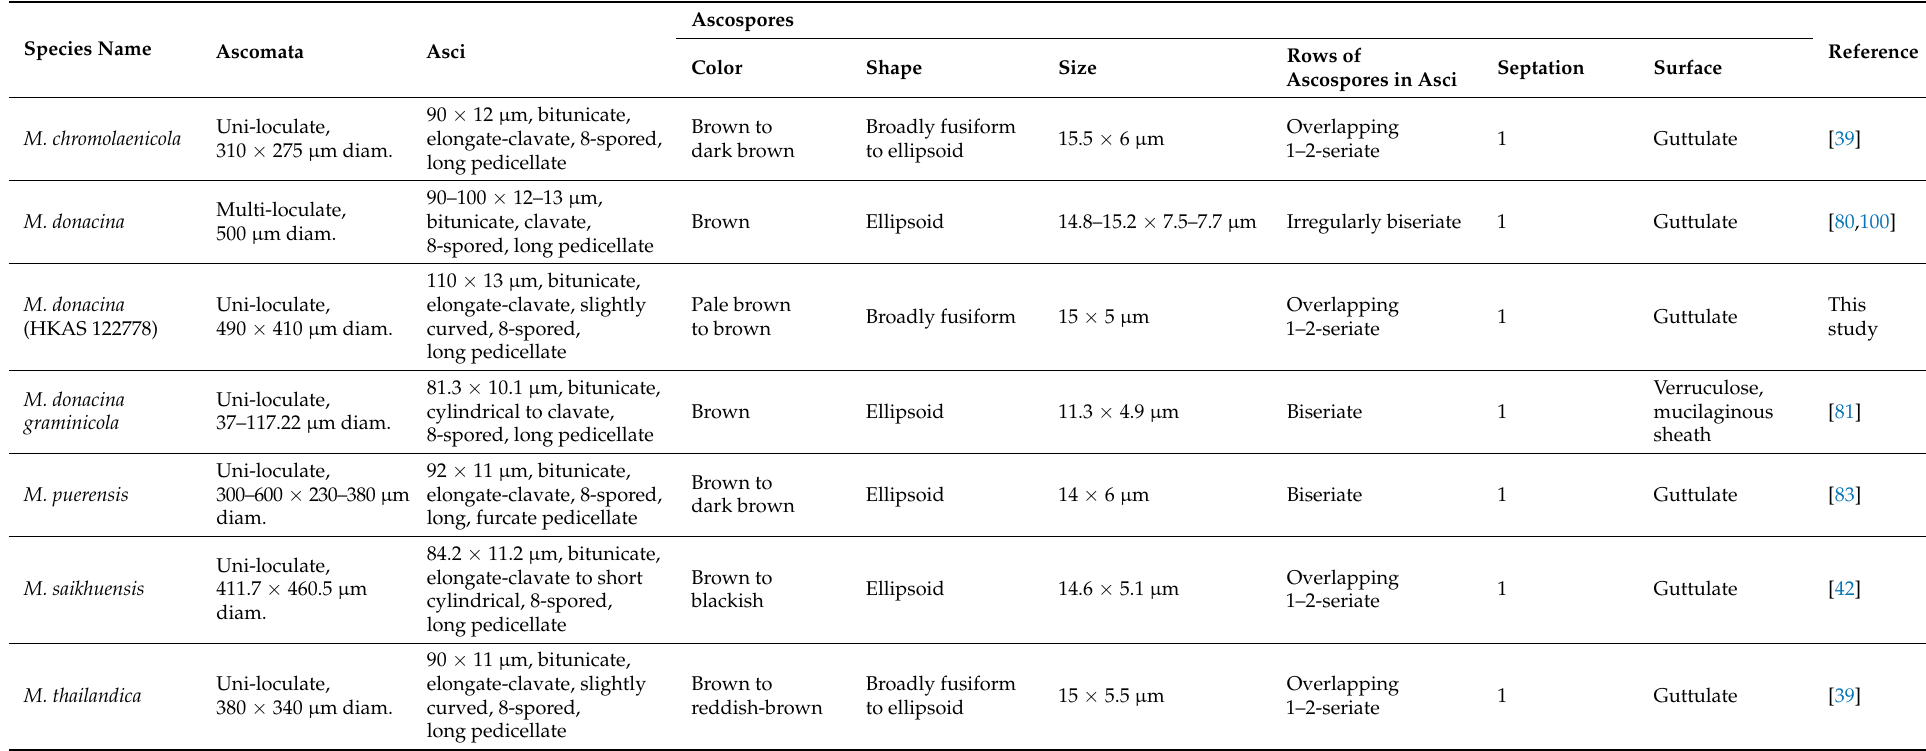
Table 2. Synopsis of the morphological characteristics of Montagnula